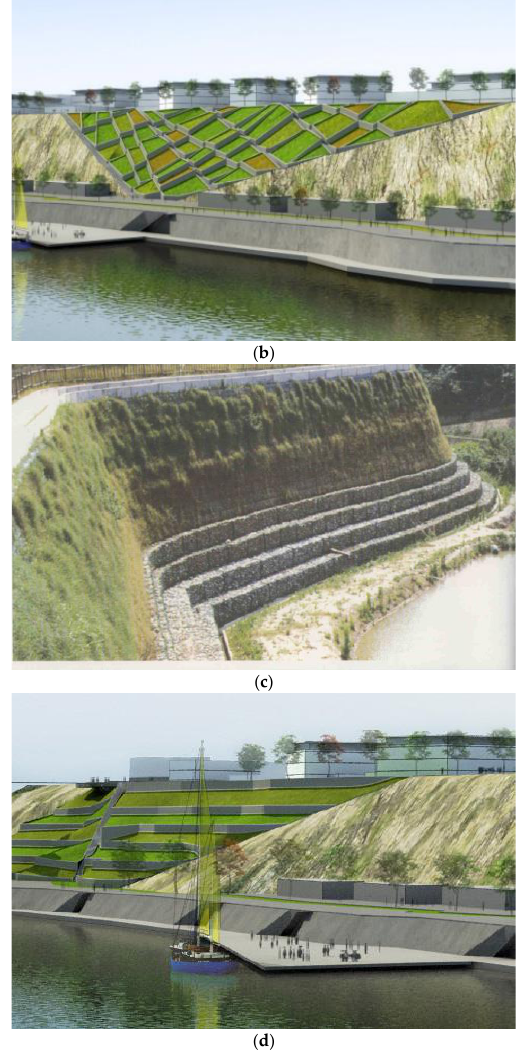
Figure 8. ( a ) Bio-shotcrete; ( b ) greenery in cassettes; ( c ) protective greenery, cascading decoration, and sub-wall; ( d ) cascading landscaping and bio-shotcrete (https://www.sllistbeo- grad.rs/pdf/2019/110-2019.pdf, accessed on 28 August 2022).